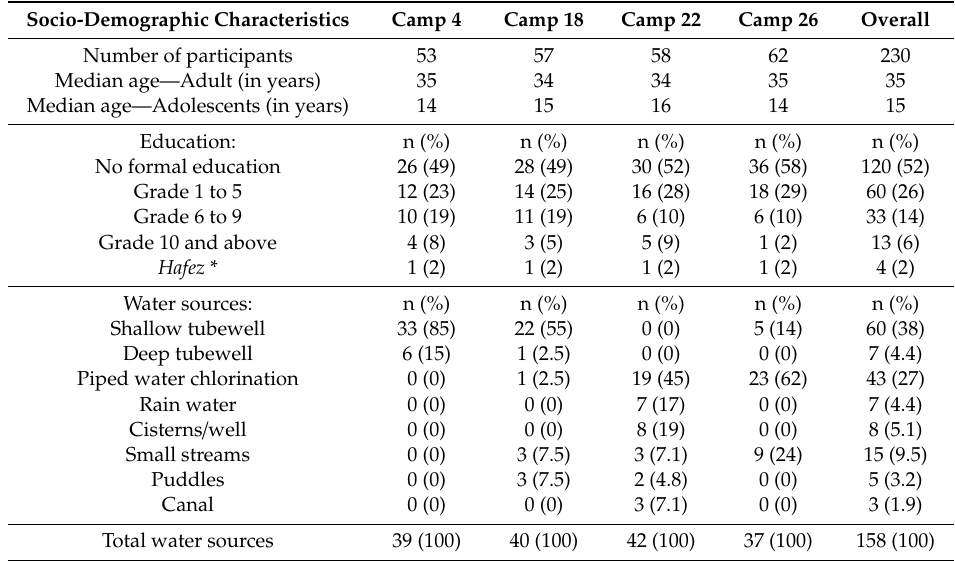
Table 1. Characteristics of study participants and water source used, by camp.